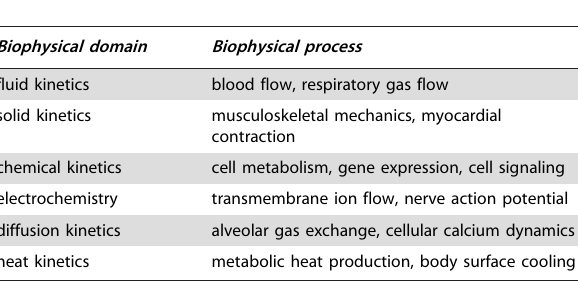
Table 1. Processes in different biophysical